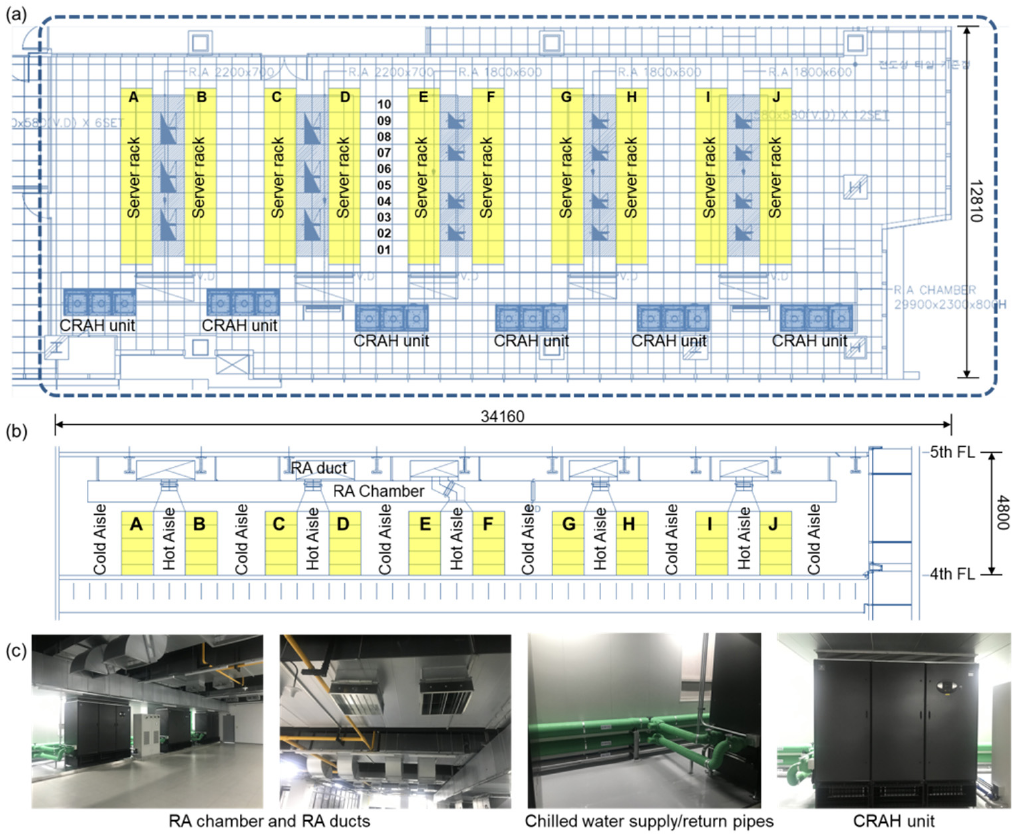
Figure 1. The test white space of information technology (IT) server room for computational fluid dynamics (CFD) analysis; ( a ) a floor plan, ( b ) a sectional view and ( c ) cooling infrastructure.